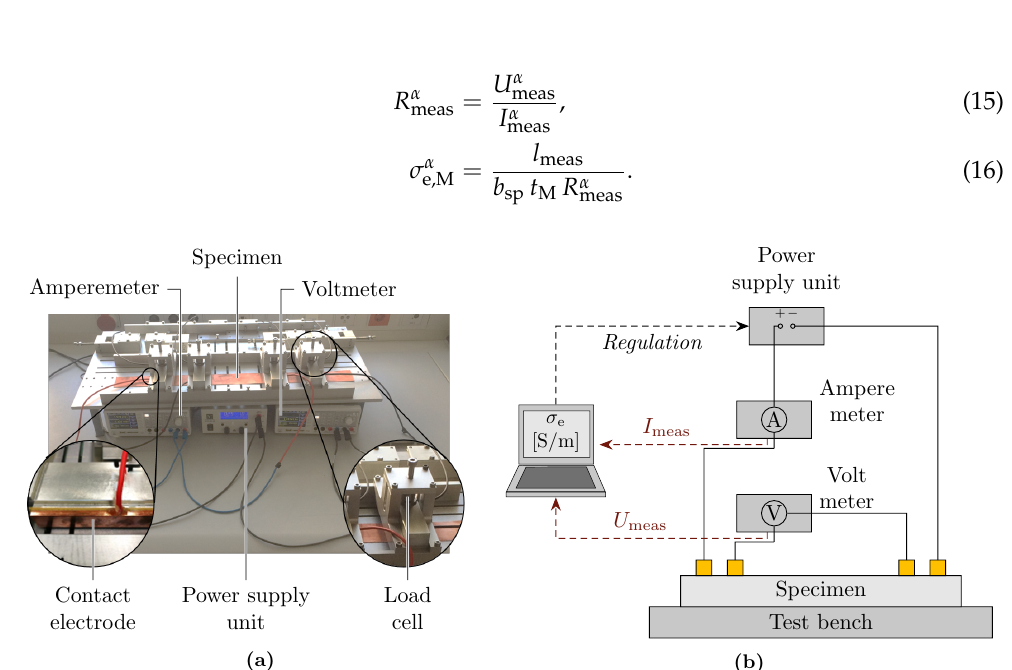
Figure 7. Experimental setup for the determination of the electrical conductivity of metal meshes: ( a ) photography and ( b ) schematic